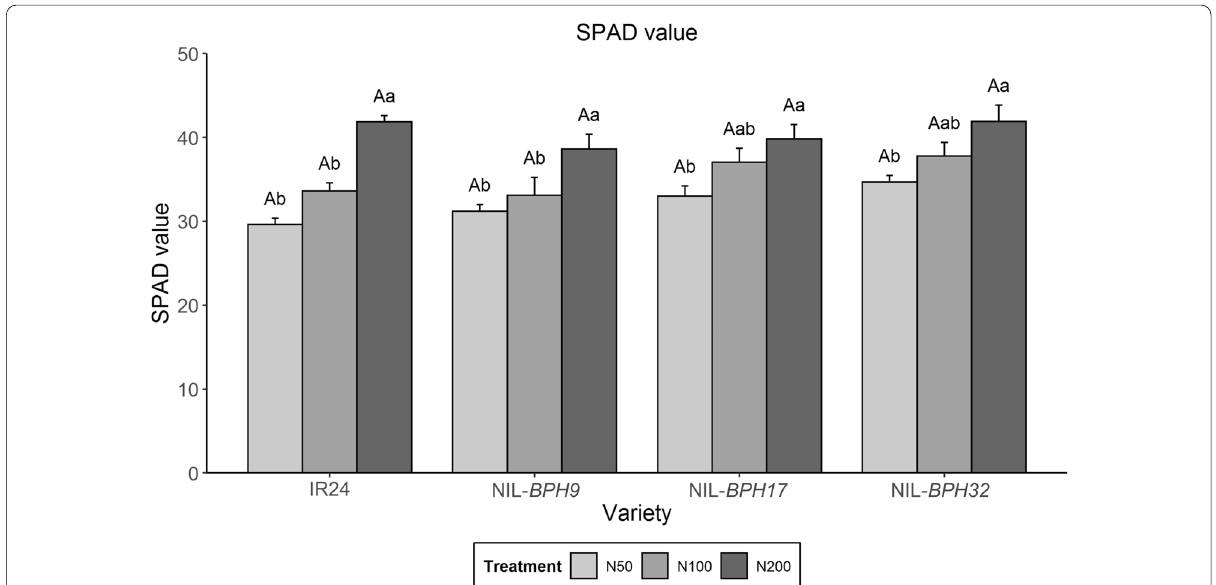
Fig. 1 The SPAD values of IR24, NIL‑ BPH9 , NIL‑ BPH17 , and NIL‑ BPH32 under different nitrogen regimes (N50, N100, and N200). Means in each column followed by the same capital letter do not differ significantly among varieties ( p < 0.05). Means in each column followed by the same lowercase letter do not differ significantly among different nitrogen treatments. The error bars indicate the